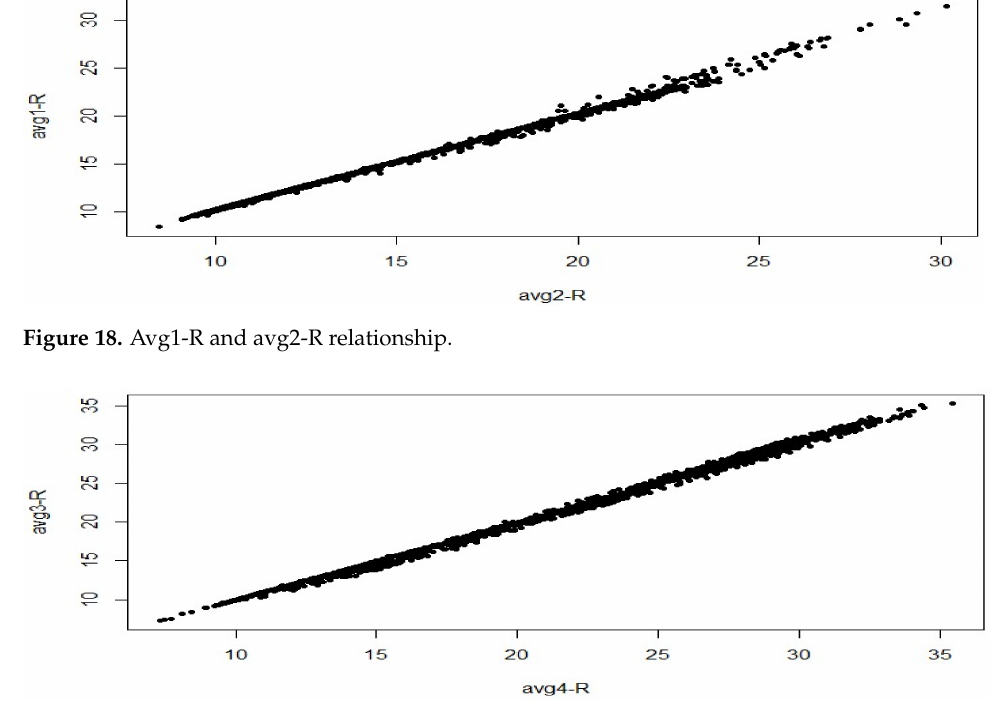
Figure 19. Avg3-R and avg4-R